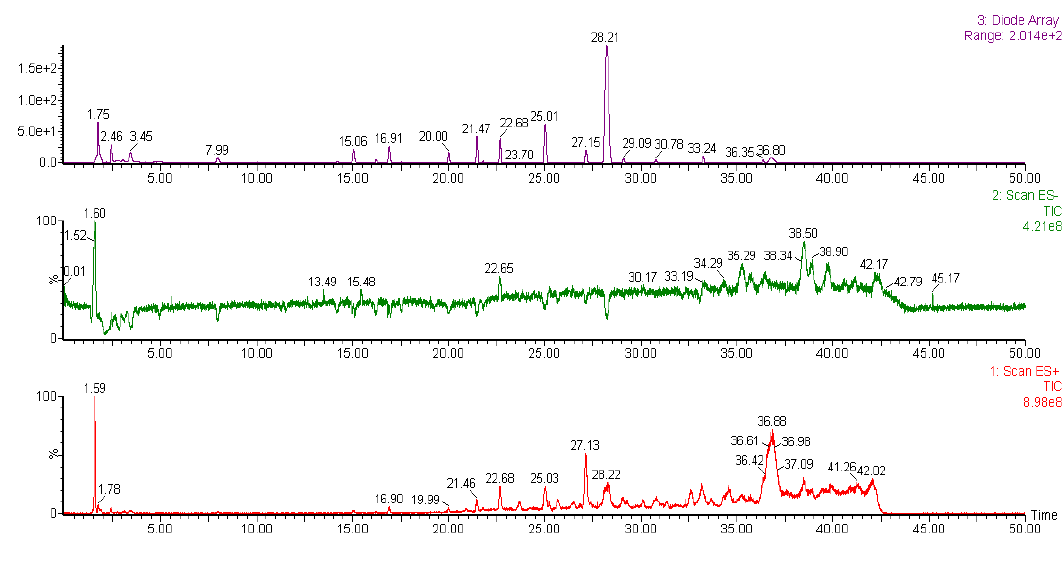
Figure 9. The LC-MS chromatogram of the methanol extract of liverwort.